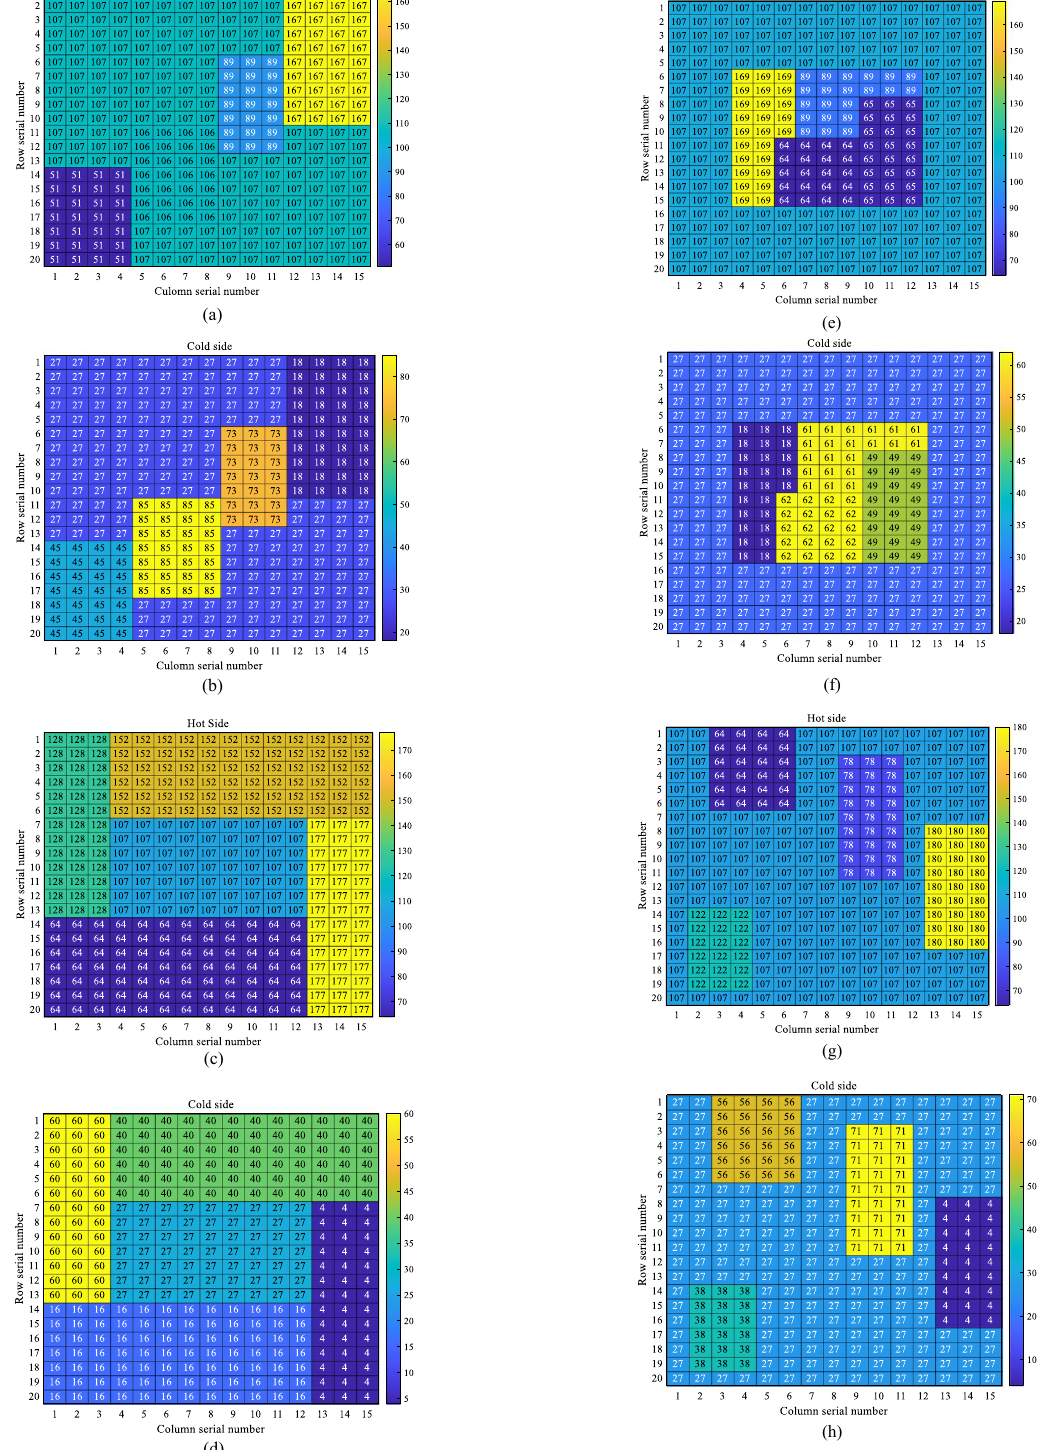
15) TEG system: a , b diagonal, c , d outer, e , f inner, g , h ×